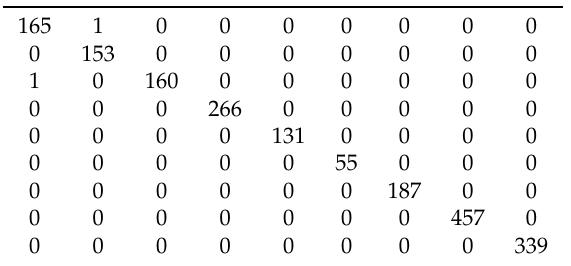
Table 2. Confusion matrix corresponding to C2R-CNN training evaluation with 100 epochs when 9 pose classes are considered.